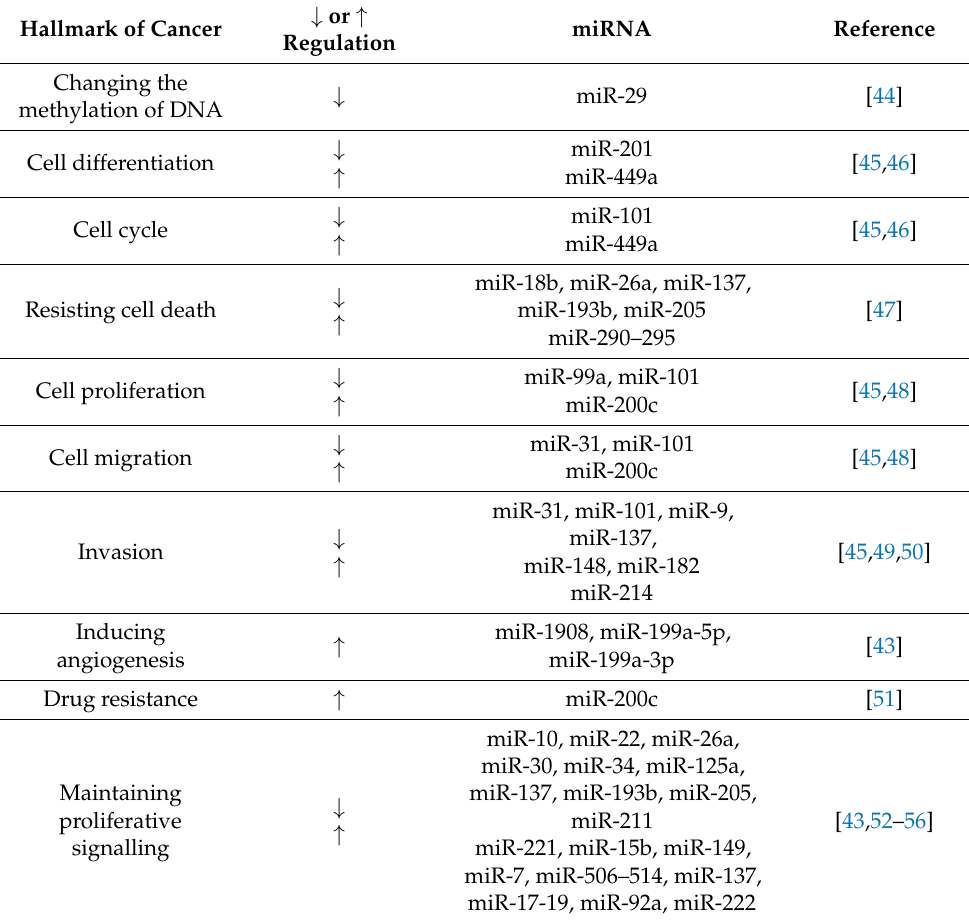
Table 1. MiRNA affected progression in